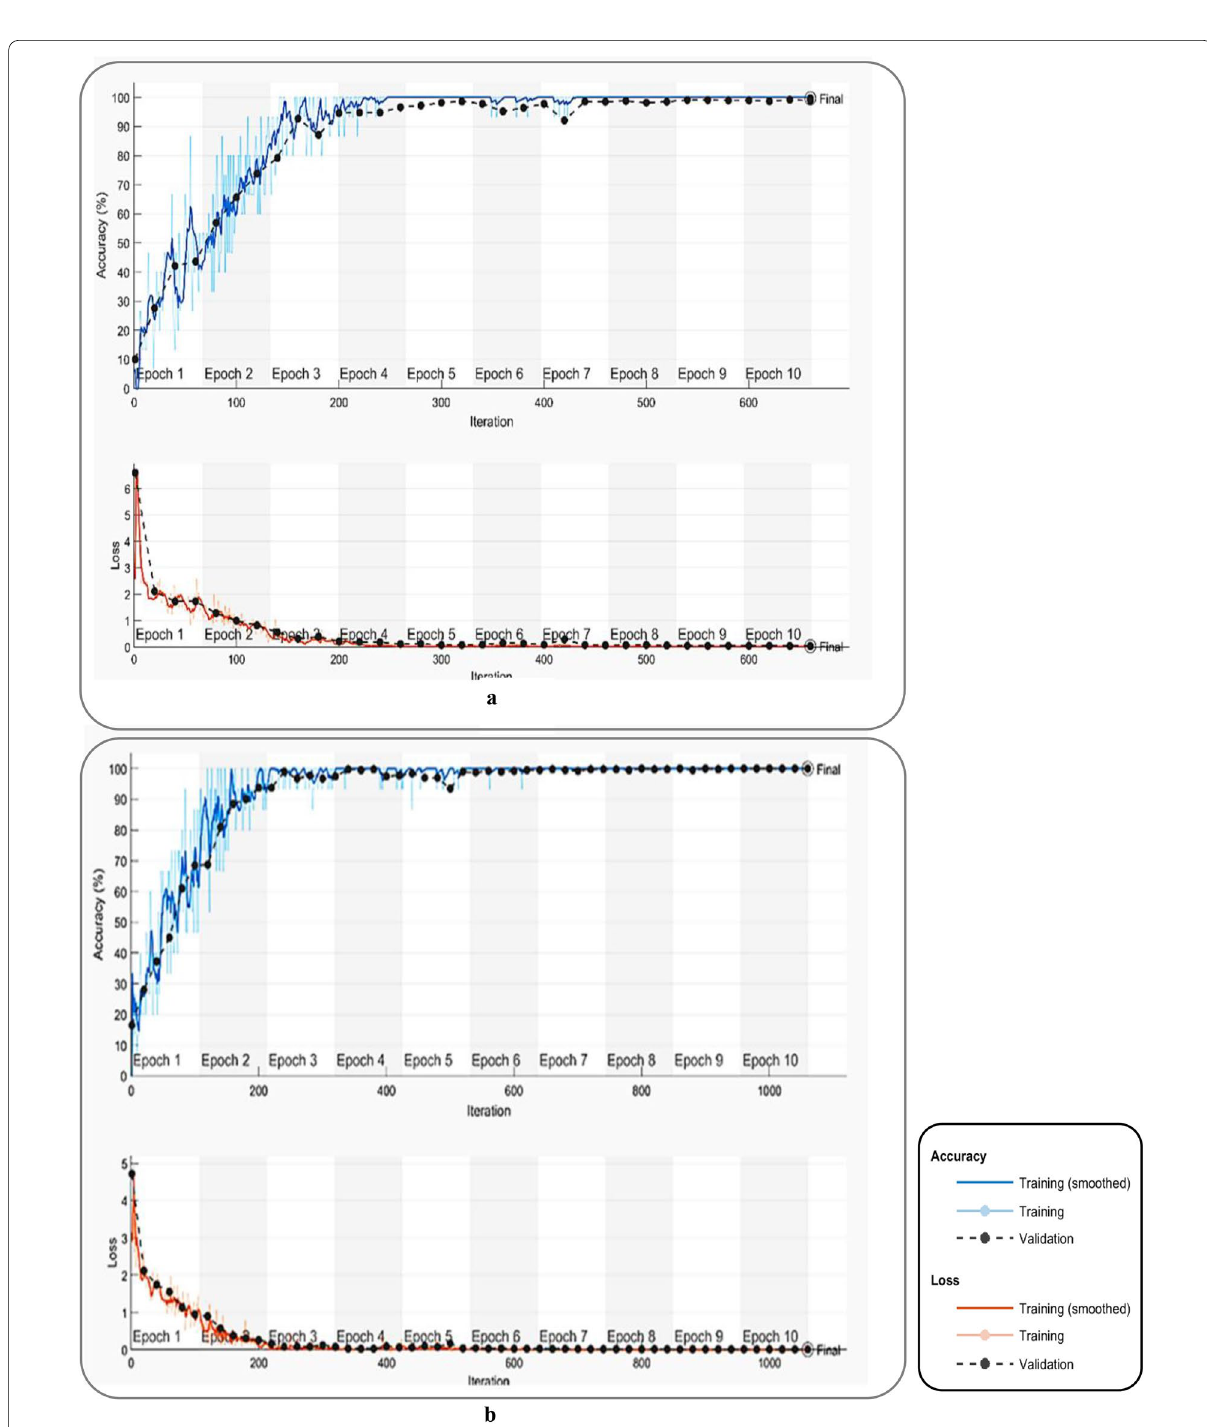
Figure 13 Examples of the training progress of the RGBVI-CNN for a 50% training data, and b 70% training